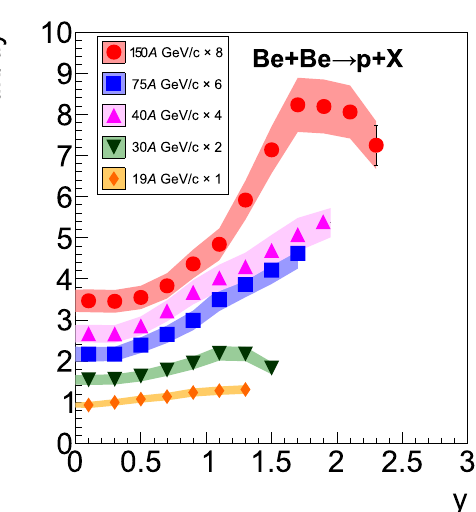
Fig. 2 Rapidity spectra of protons produced in the 20% most central Be+Be collisions. Curves depict Gaussian fits used to determine mean multiplicities. The following factors scaled spectra for different beam momenta for better visibility: 150 A GeV/ c by factor 8, 75 A GeV/ c by factor 6, 40 A GeV/ c by factor 4 and 30 A GeV/ c by factor 2